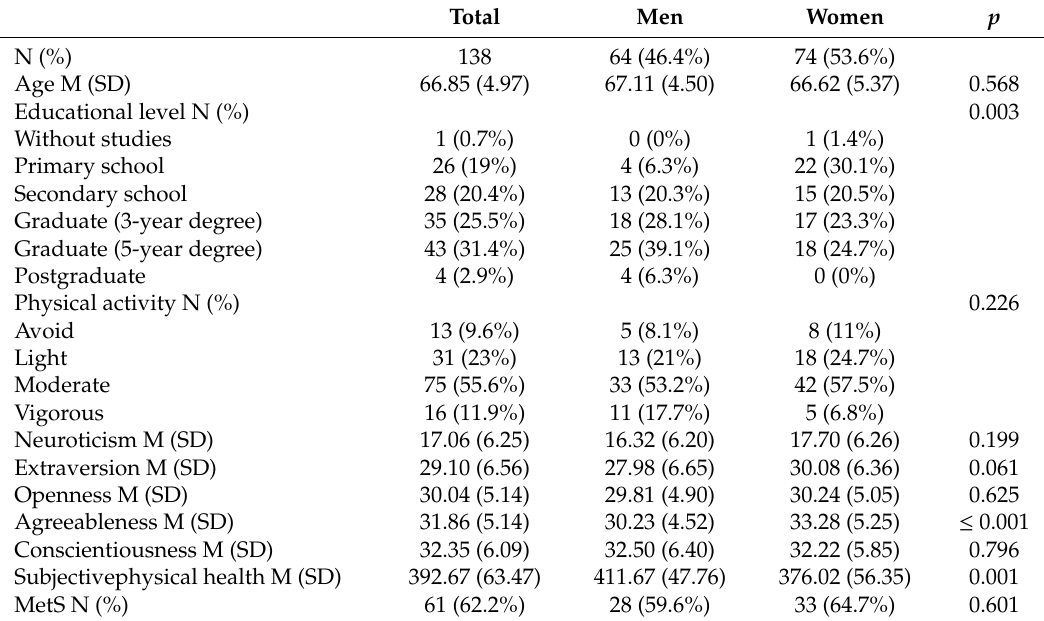
Table 1. Characteristics of the total sample and for men and